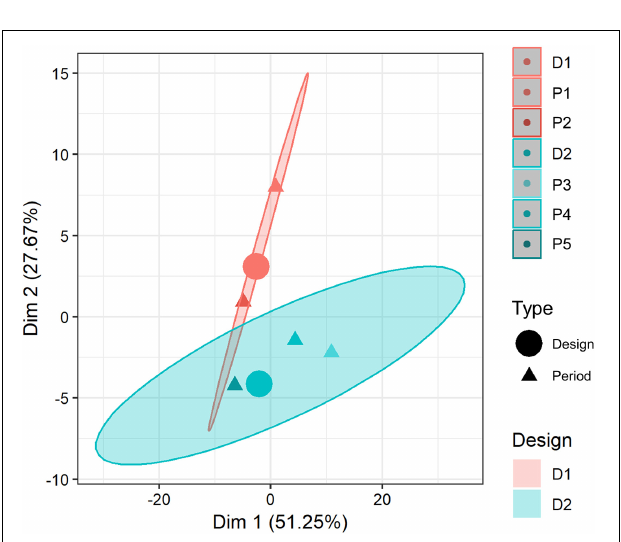
FIGURE 8 | PCA distribution per design and